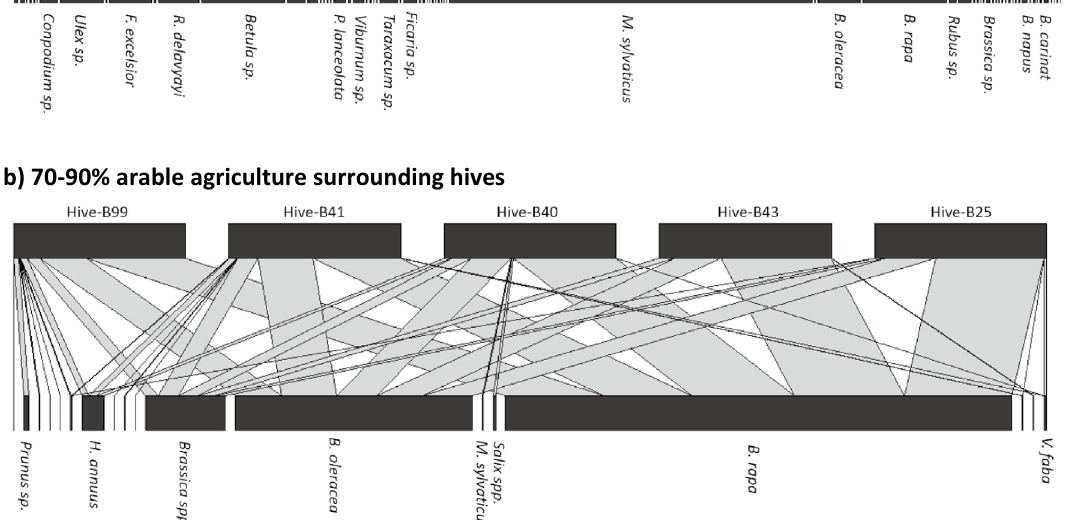
Figure 4. We derived bipartite food webs determined from DNA barcoding of pollen from honey. This allowed us to establish foraging associations between hives and plants in landscapes with different extents of arable and horticultural land. Here we show an examples of these webs of foraging relationships for five randomly picked hives (top rectangles) and forage plant (bottom rectangles) located in landscapes of either low (0–10% ) or high (70–90%) arable and horticultural cover. Both webs are determined from honey samples collected early in the season (June or before). We have standardised these webs to show only five randomly chosen hives as different landscapes had different numbers of hives which would make comparing an overall interaction web hard to interpret. Only plant names representing important feeding relationships are included, where: B. = Brassica , H. = Helianthus , M. = Myosotis , V. = Vicia , F. = Frazinus , R. = Rhododendron , P. = Plantago